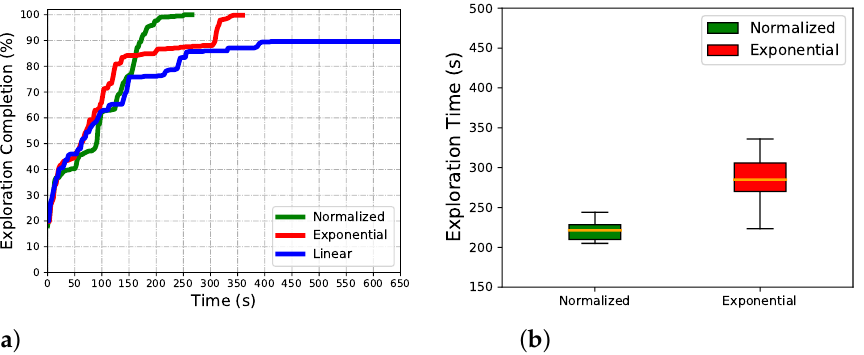
Figure 10. Algorithm comparison in maze scenario. ( a ) Exploring completion degree curve. ( b ) Total completion time.